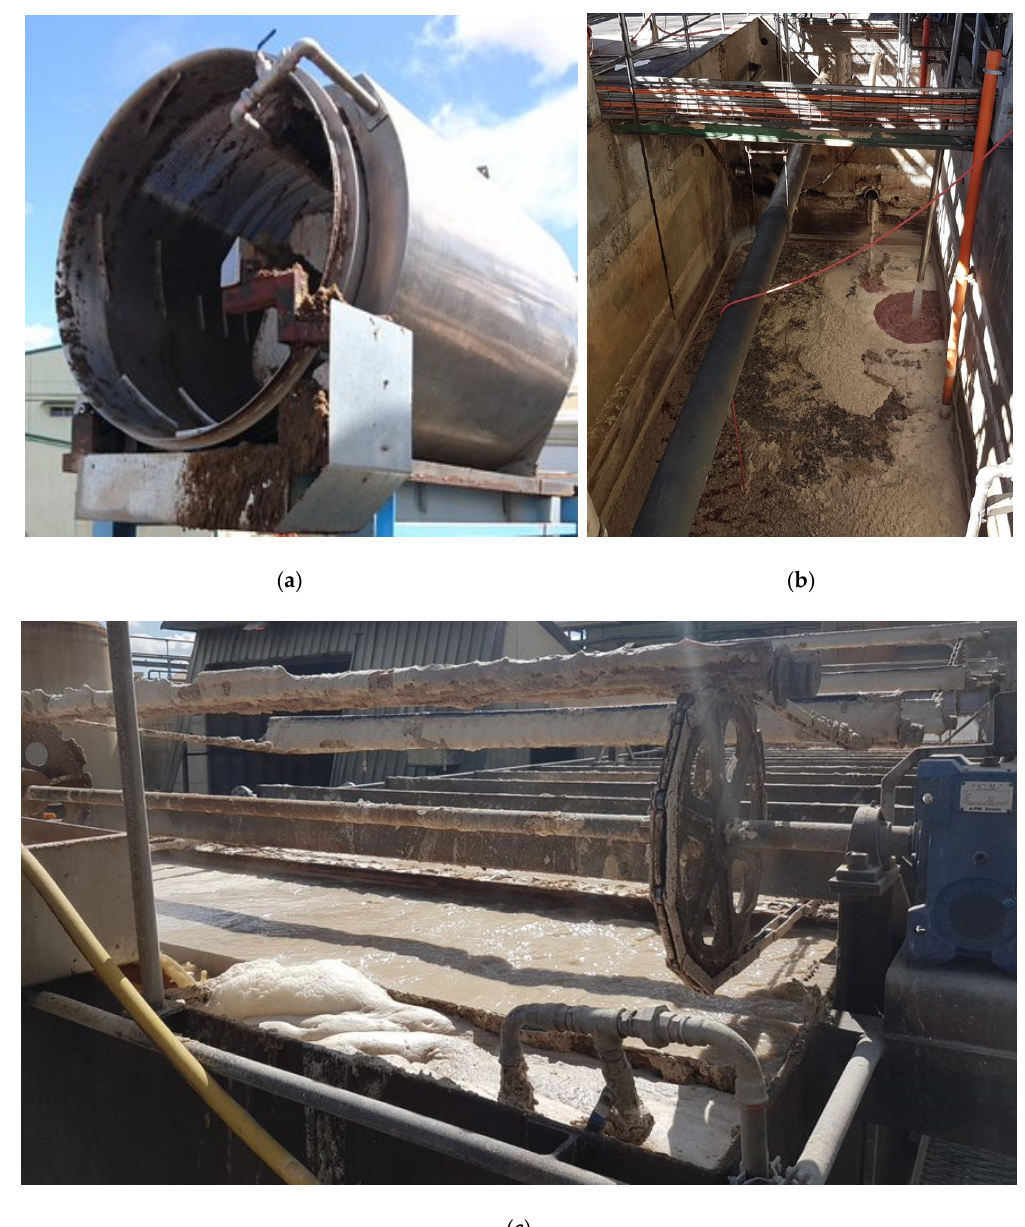
Figure 1. Equipment used to remove solids from wastewater include, but are not limited to: ( a ) Rotary screens; ( b ) Save-alls and; ( c ) Dissolved-air flotation (DAF).